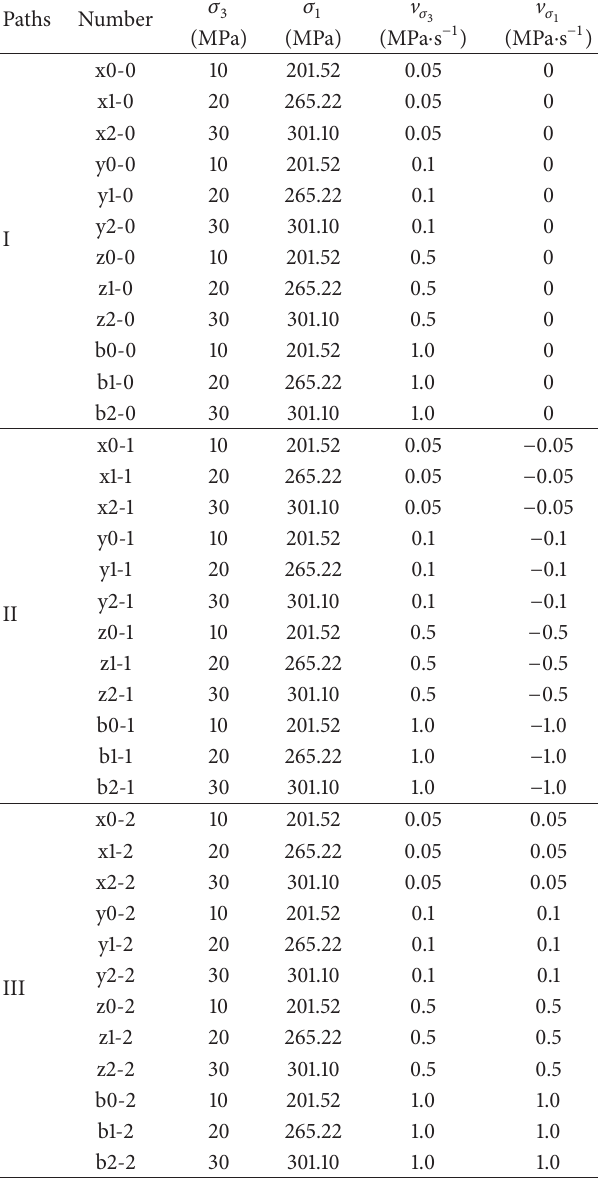
Table 1: Initial geostress condition of various rock